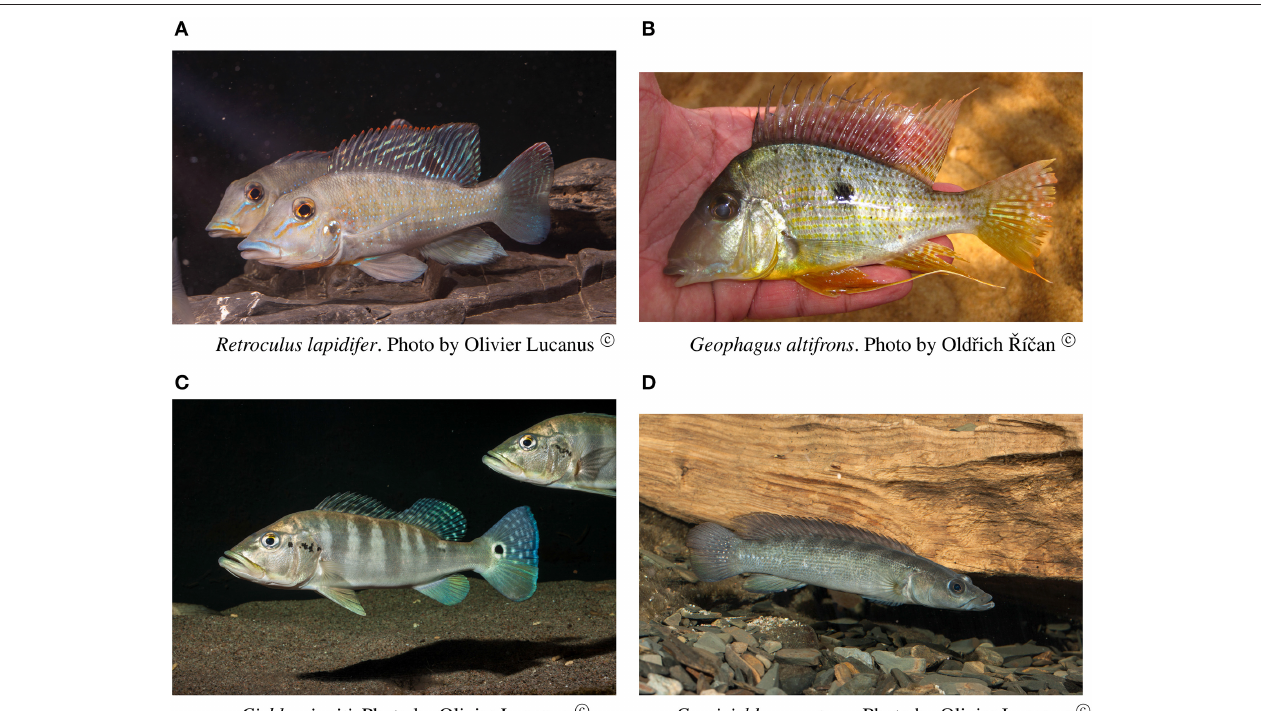
FIGURE 6 | Cichlid species analyzed in this